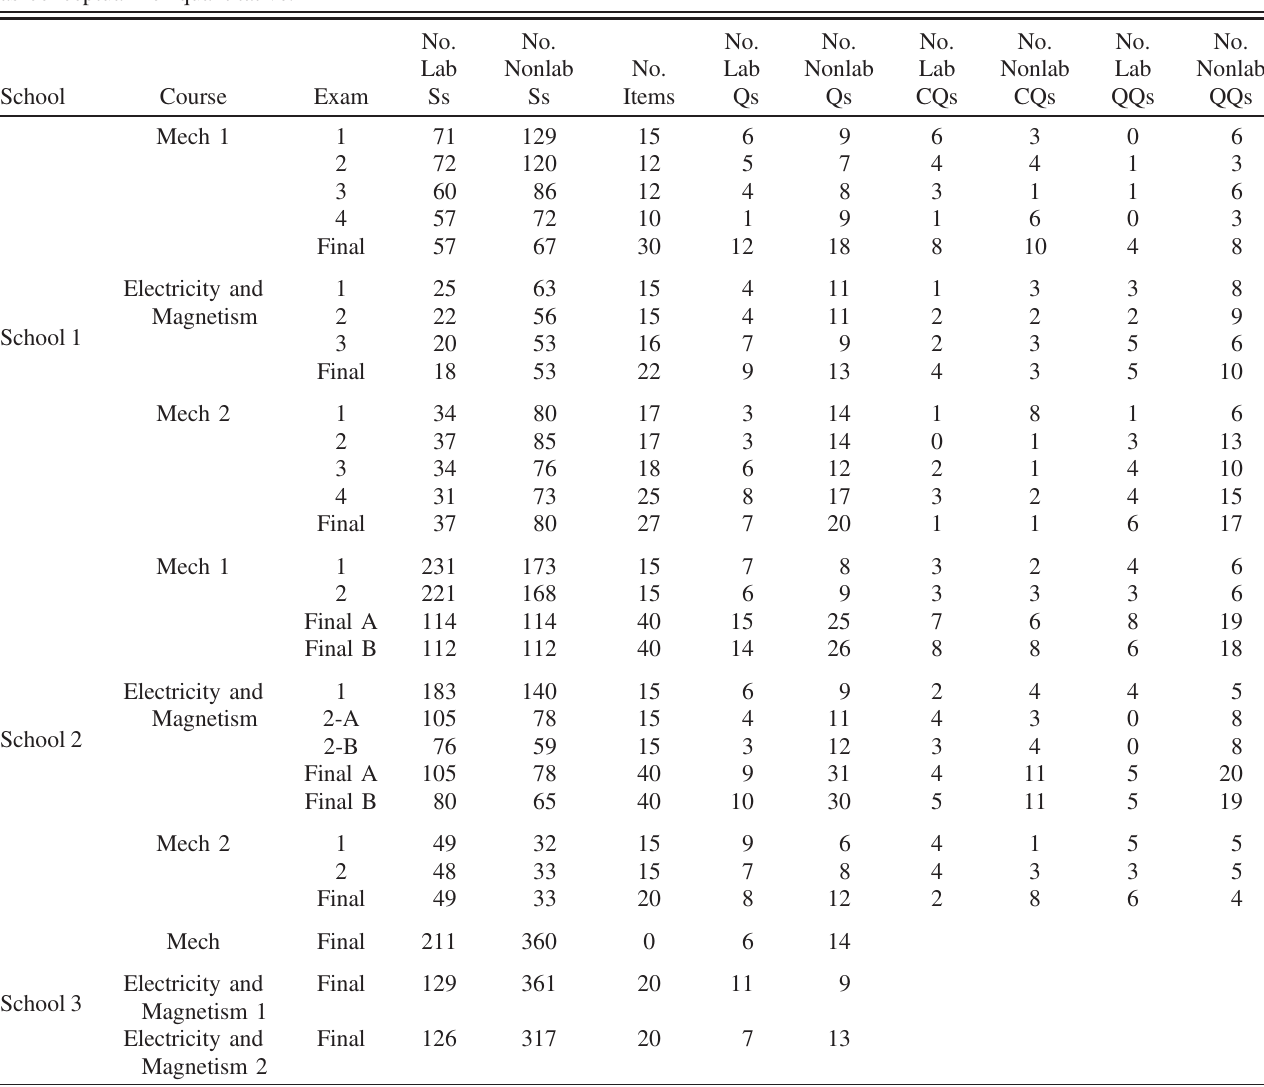
TABLE I. The participants at each institution and course are broken down by the number of students enrolled in the lab (No. Lab SS) and not enrolled in the lab (No. Non-Lab SS). The associated exams are described by the number of lab-related and non-lab-related items (Qs), conceptual items (CQs), and quantitative items (QQs). Note that some items (such as factual recall questions) were not categorized as conceptual nor